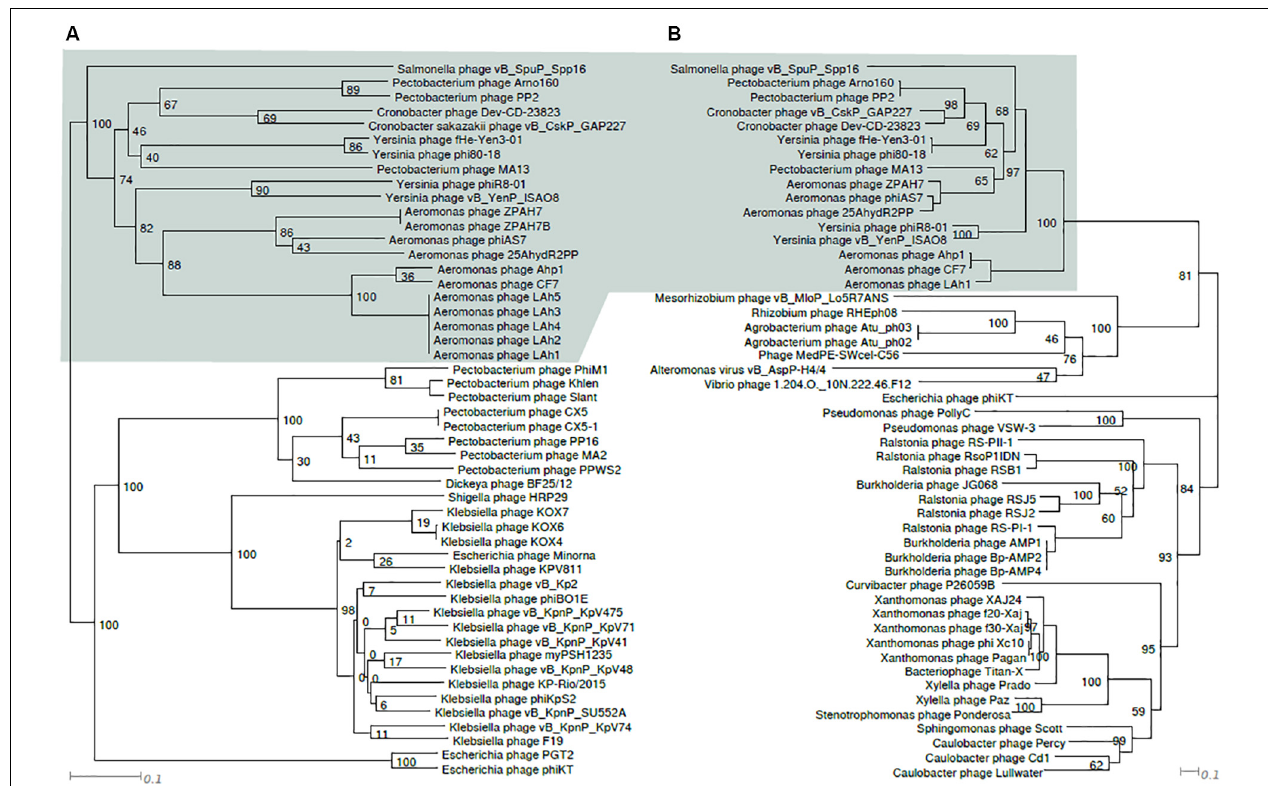
FIGURE 3 | Tanglegram comparing topologies of genome based (A) and RNAP protein sequence based (B) phylograms of taxa closely related to φ 80-18. Node labels are bootstrap values. The shaded area indicates similarly, composed